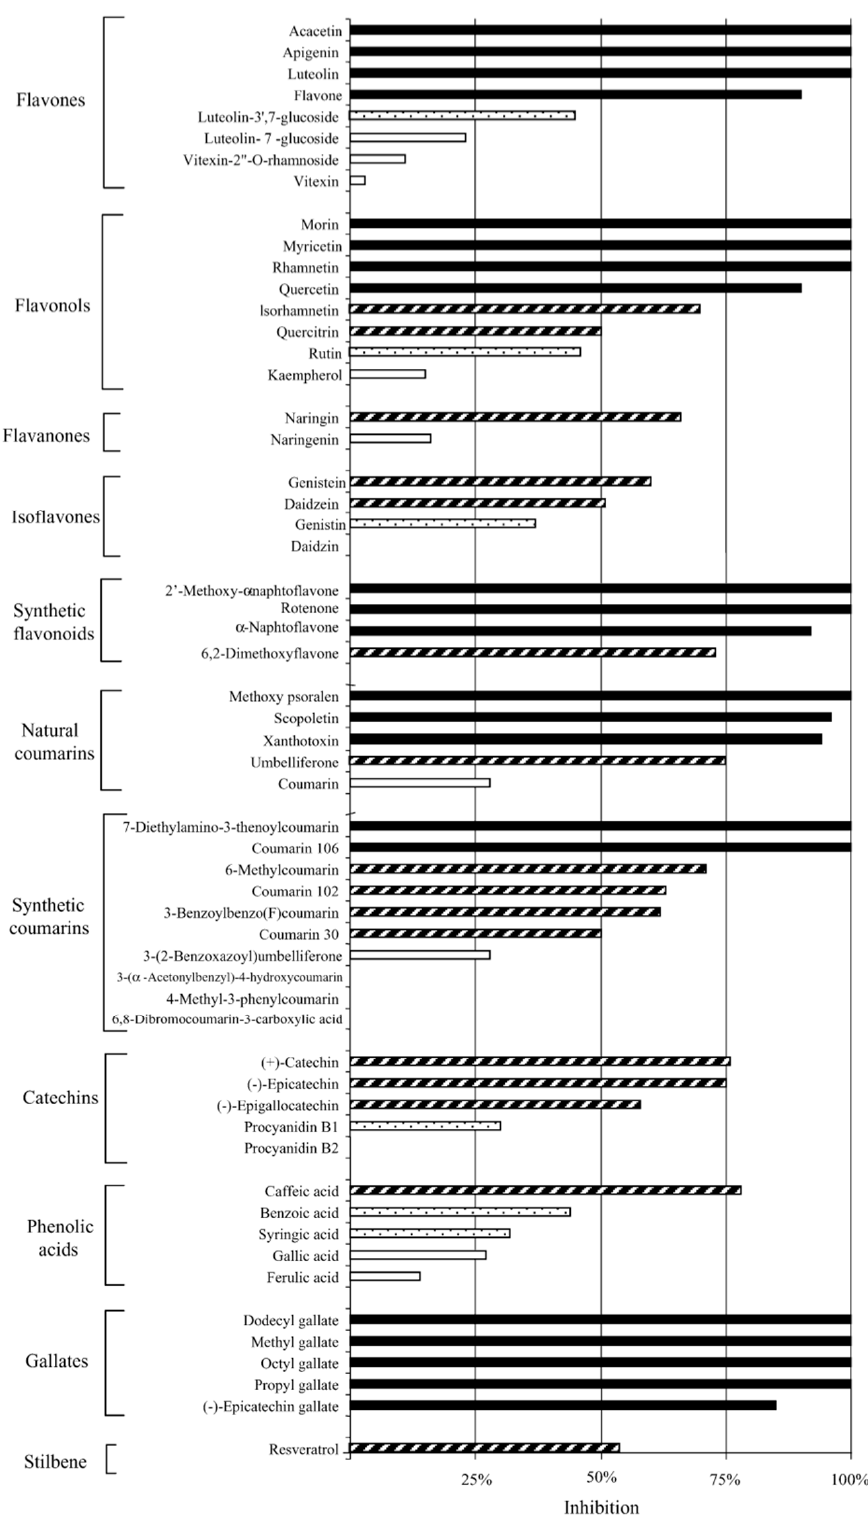
Figure 3. Inhibition percentages of various natural and synthetic polyphenolic compounds against C. pneumoniae at 50 µ M concentration ( n = 4 or more). Activity is determined in comparison to controls: highly active (black bar) = 85%–100% inhibition; active (striped bar) = 50%–84%; moderately active (black dotted bar) = 30%–49%; inactive (white bar) = <30%. Adapted with permission from [43]. Copyright 2005 Elsevier Inc.